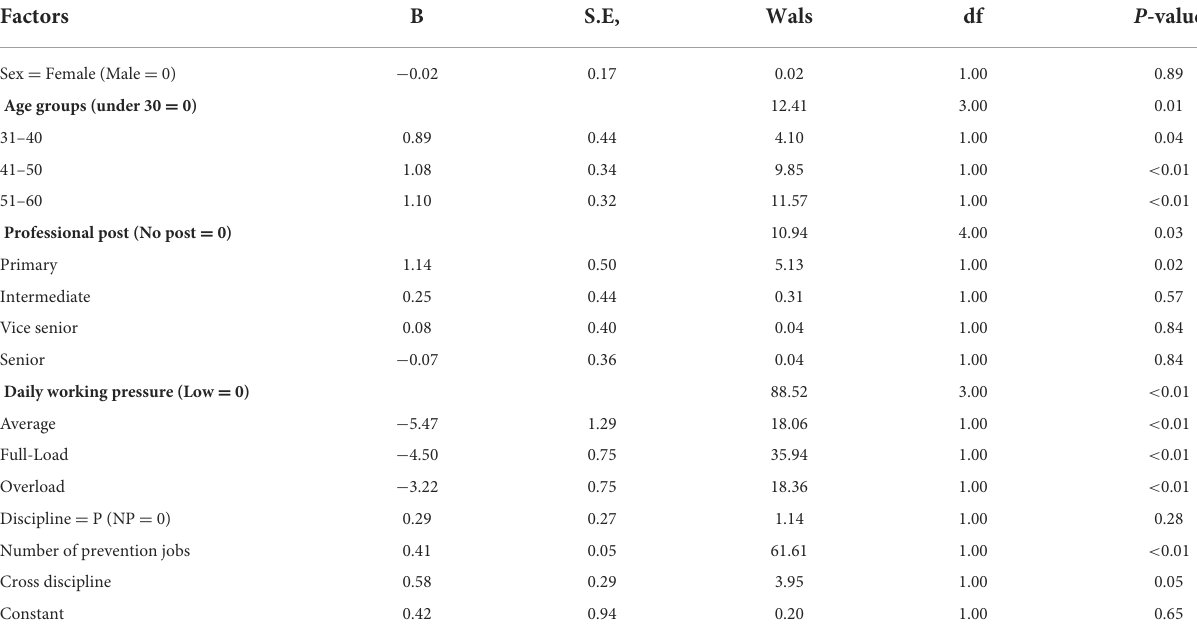
TABLE 1 Analysis on influencing factors of overload occupational stress during COVID-19 within Beijing disease prevention and control system. B